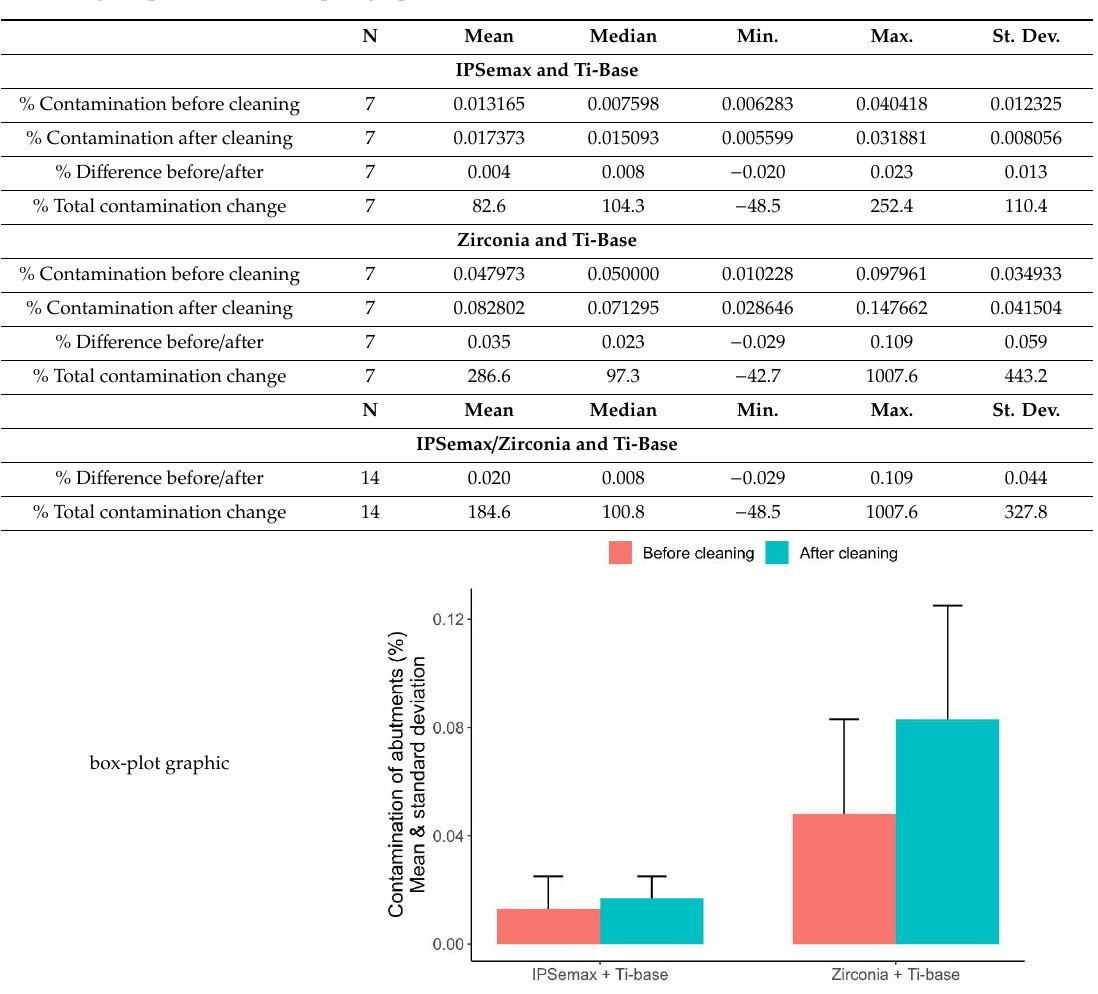
Table 9. Projected surface contamination of hybrid abutment samples (IPSemax and Ti-Base, Zirconia and Ti-Base) before and after cleaning in percent; mean, median, min. and max. total contamination change in percent; and box-plot graphic. N Mean Median Min. Max. St. Dev.